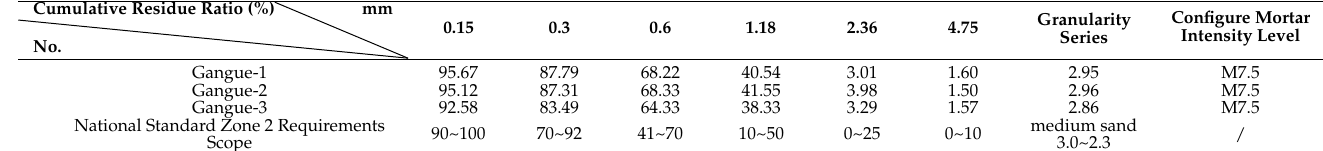
Table 7. The screen residue rate of benchmark sand.